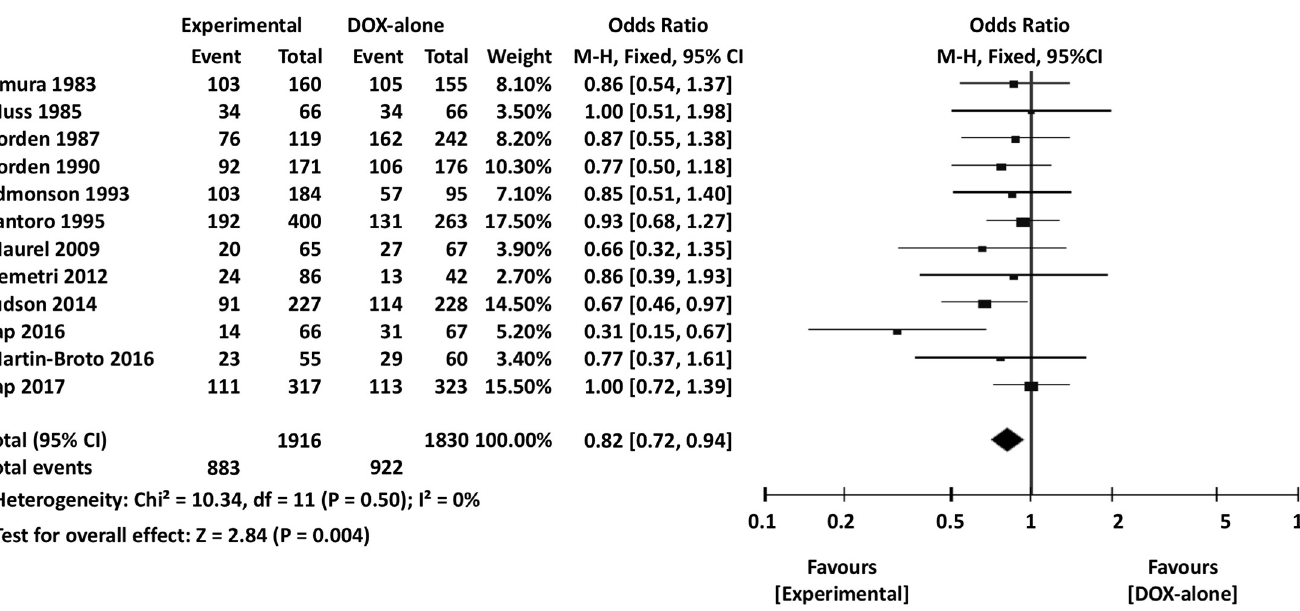
Fig 9. Comparisons of doxorubicin alone vs doxorubicin-based combination chemotherapy: Forest plots of 1-overall survival. M-H, Mantel-Haenszel; CI, confidence interval.